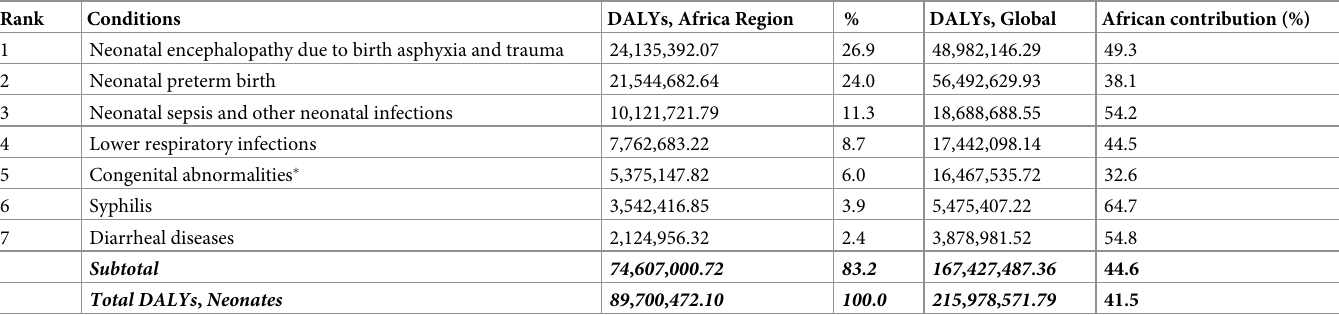
Table 3. Leading conditions in neonate age cohort in the Africa region, global and African region DALYs contribution, 2019.